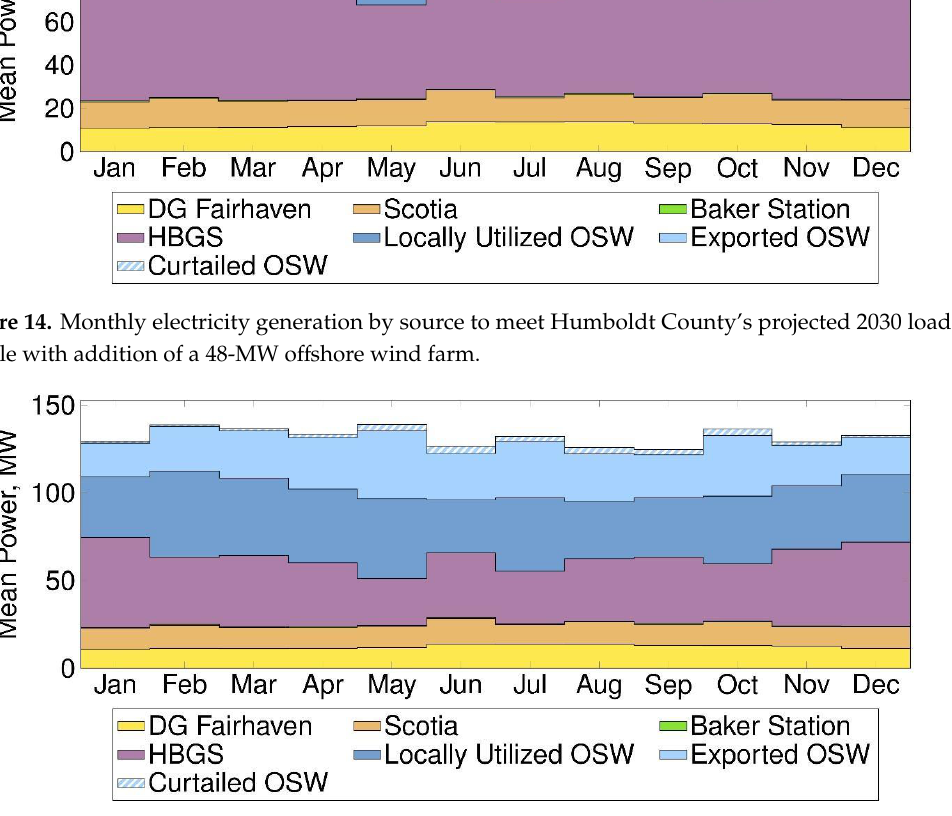
Figure 15. Monthly electricity generation by source to meet Humboldt County’s projected 2030 load profile with addition of a 144 MW offshore wind farm.